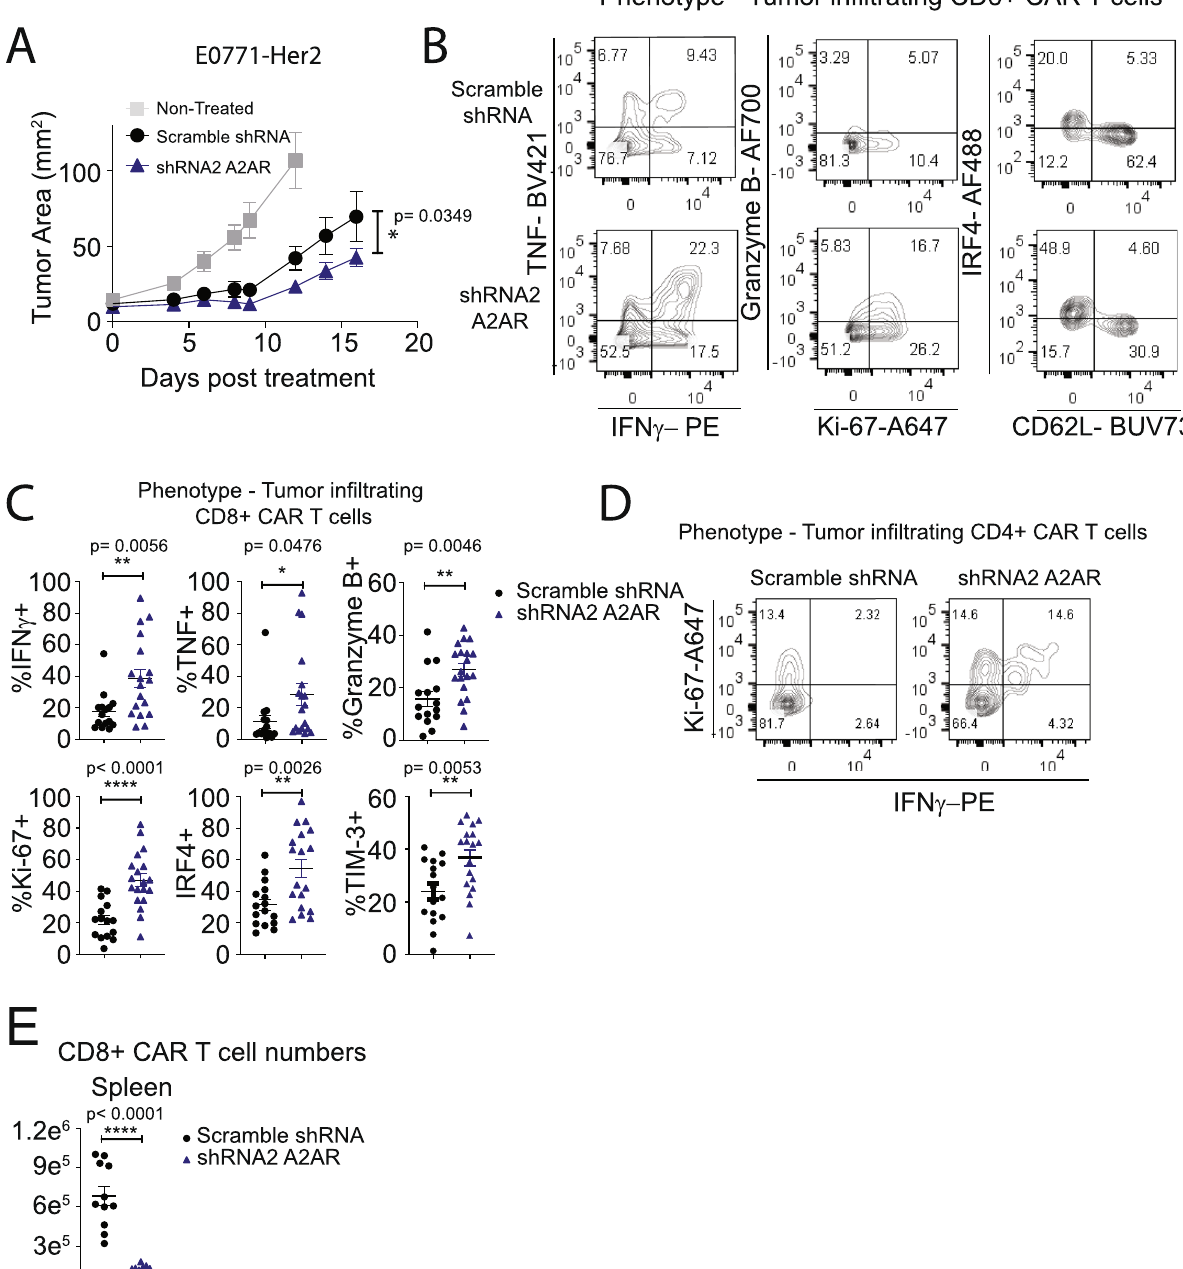
Fig. 3 A 2A R knockdown promotes an effector-like CAR T-cell phenotype in vivo. C57BL/6 Her2 mice were injected with 2 × 10 5 E0771-Her2 tumor cells into the fourth mammary fat pad and treated with anti-Her2 CAR T cells transduced and cultured in IL-7 and IL-15 as per Fig. 2G. Once tumors were established, 1 × 10 7 CAR T cells were injected intravenously on two subsequent days following 4-Gy total body irradiation. Mice were treated with 50,000U of IL-2 on days 0 – 4 post CAR T-cell treatment. A Tumor growth shown as the mean ± SEM of n = 5 (CAR T-cell treated) or 6 (nontreated) mice per group from a representative experiment: n = 2, * p < 0.05, two-way ANOVA. B – E Spleens and tumors were excised 9 days post treatment and the number and phenotype of NGFR + CAR T cells determined by fl ow cytometry. B , D Expression from concatenated samples ( n = 7 per group) from a representative experiment. C , E Data represent the mean ± SEM of n = 11 – 19 mice + from 2 ( E ) or 3 ( C ) replicate experiments (see + below for details). Each data point represents an individual mouse. * p < 0.05, ** p < 0.01, *** p < 0.001, **** p < 0.0001, unpaired t test. + IFN γ , TNF, TIM-3 control n = 15, shRNA A 2A R n = 18, Granzyme B and Ki-67, control n = 15, shRNA A 2A R n = 19, IRF4, control n = 16, shRNA A 2A R n = 18, numbers in spleen control n = 11, shRNA A 2A R n = 13. Data from some control samples are also presented in ref. 36 . Source data are provided as a Source Data fi